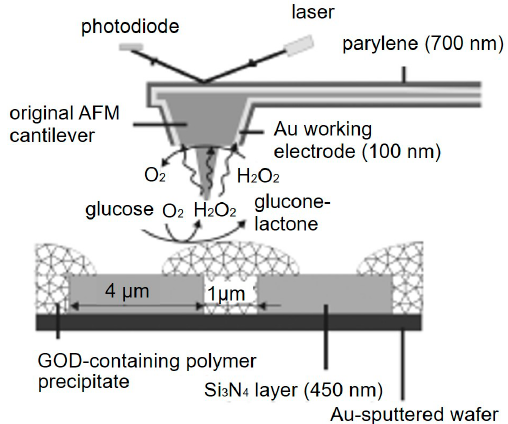
Figure 5. Schematic representation of simultaneous atomic force microscopy (AFM)-SECM